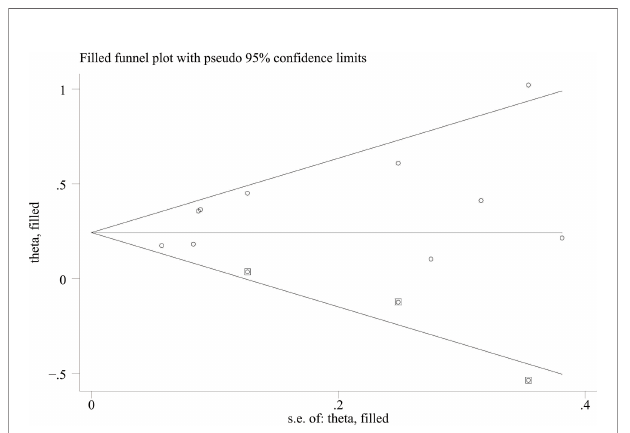
FIGURE 6 | Trimming chart of univariate analysis outcomes of baseline CRP levels and PFS.